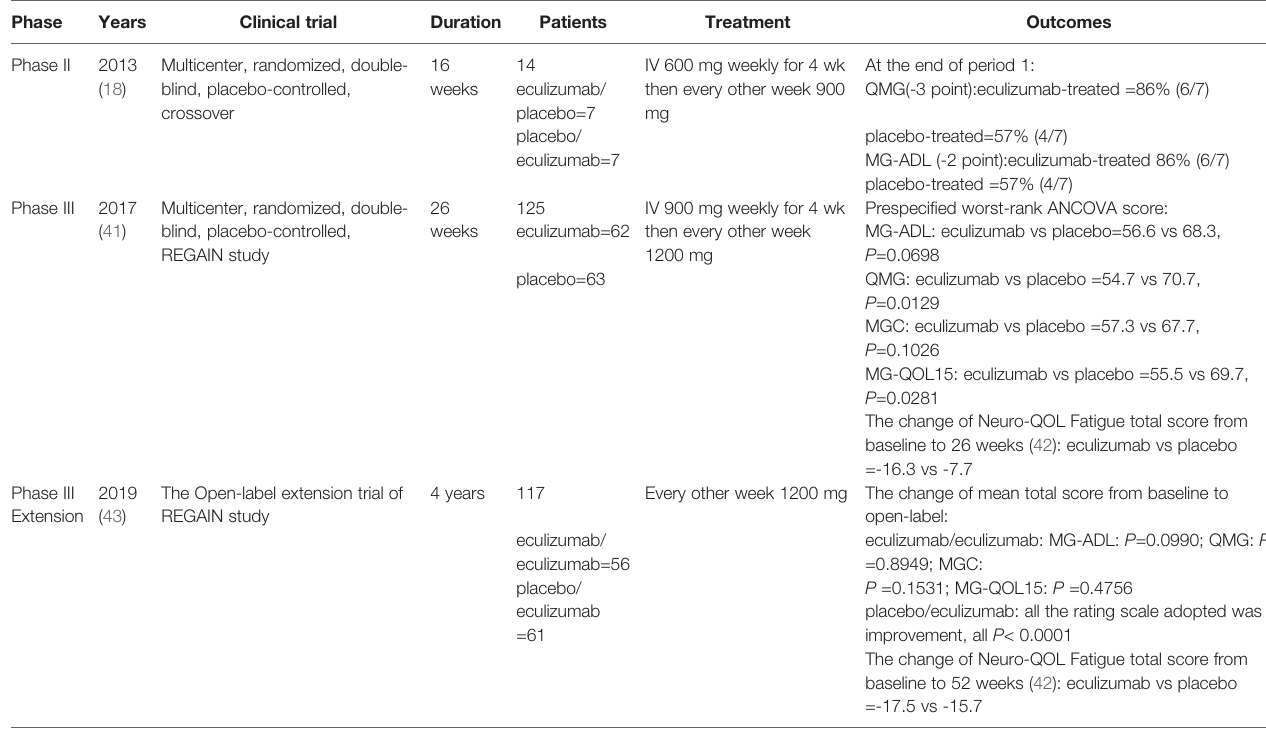
TABLE 2 | Summary of the clinical trials on eculizumab in myasthenia gravis.